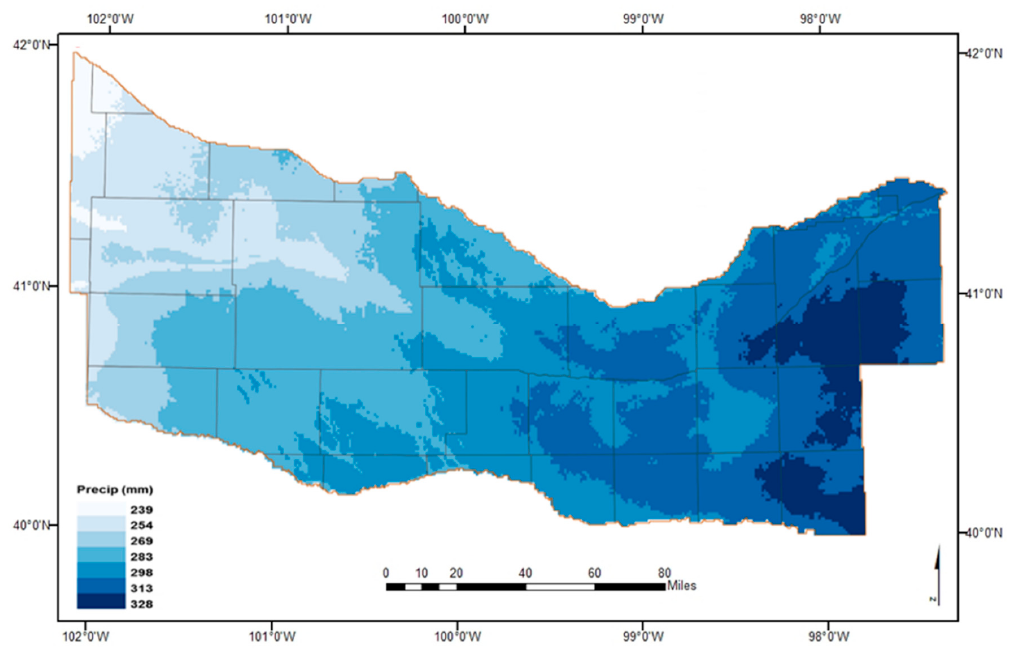
Figure 8. Normal rainfall distribution across the COHYST region during the growing season (June, July and August). Base period: 1981–2010. Data source: Prism [40]. Table 2. NEG COHYST estimated irrigated acreages (ha) and percentage from total irrigated acreages for the main crops grown in COHYST model region in 2015 growing season.